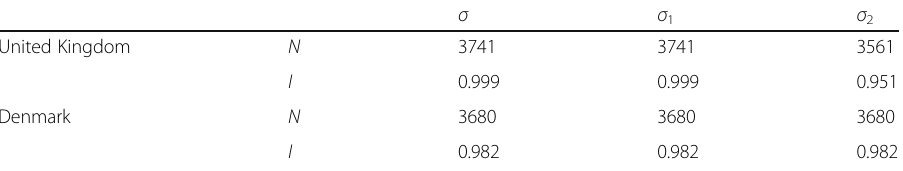
Table 4 Raftery-Lewis diagnostic for single parameters of our validating mortality forecasts for women in the UK and Denmark